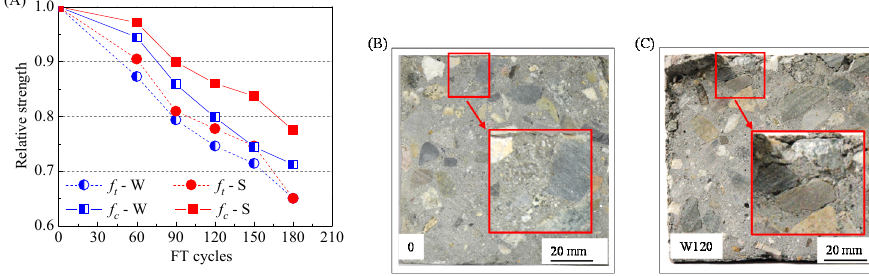
Figure 7. Evolutions of residual strength ( A ) and interfacial transition zones ( B , C ) at different freeze–thaw cycles.